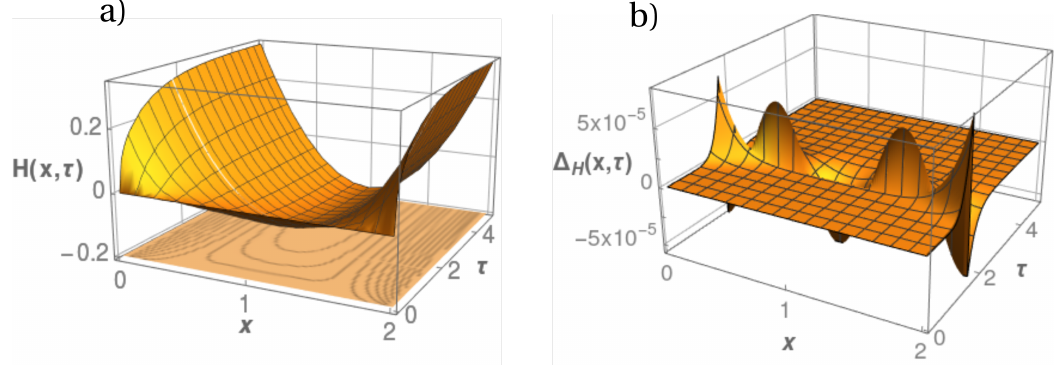
Figure A1. Illustration of ( a ) H ( x , τ ) and ( b ) deviation ∆ ( x , τ ) = H appr ( x , τ ) the approximate expression, Equation (A21) and the numerical value, Equation (A12), in the range [ 0 : 2 ] x ∈